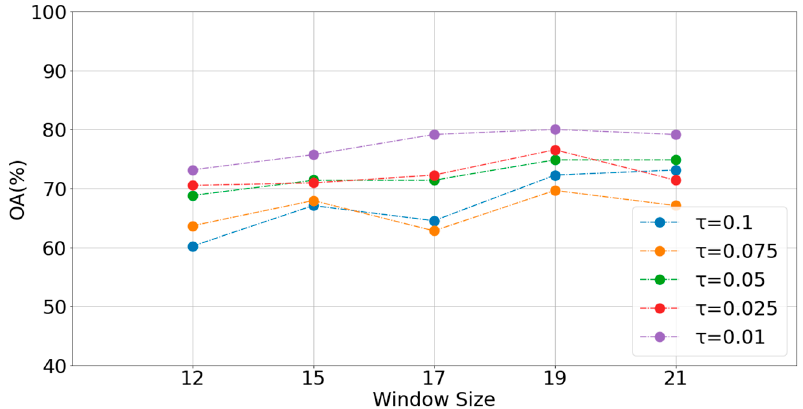
Figure 11. OA of M-SSL for τ with a different size of window.